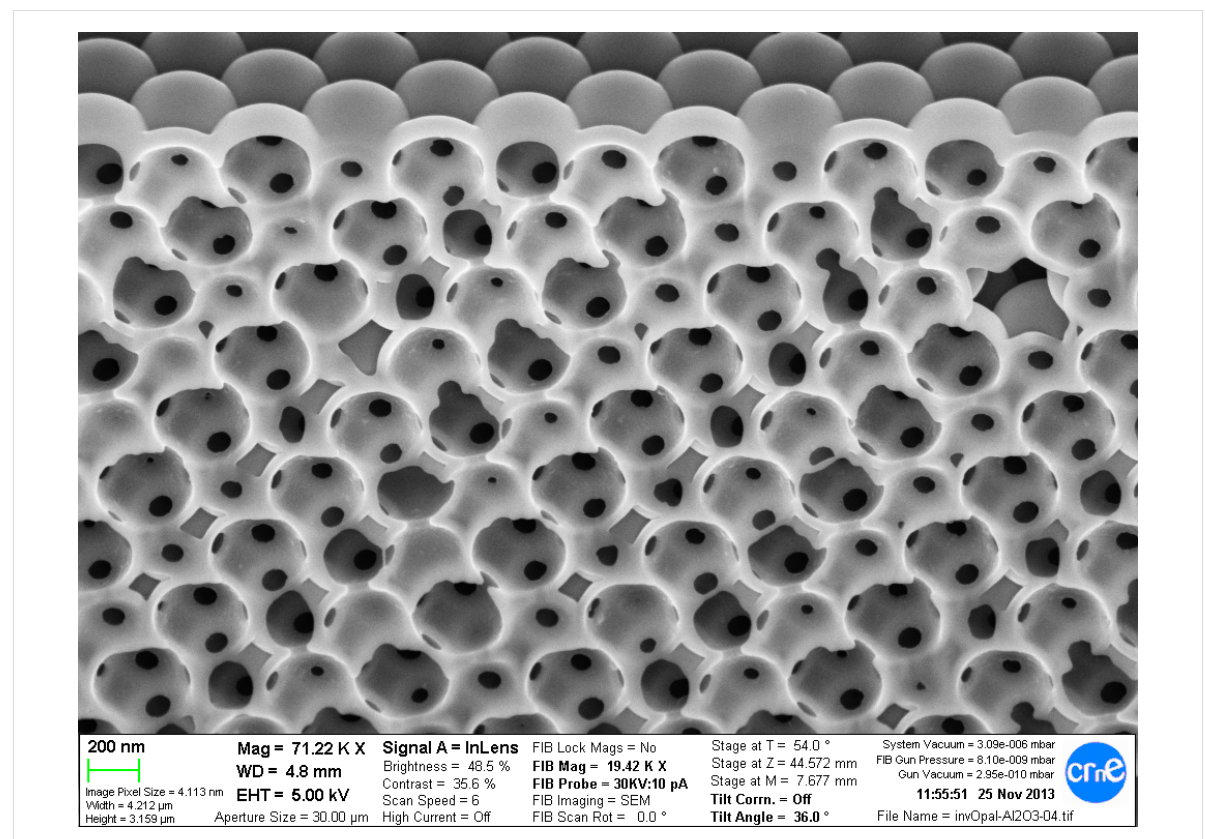
Figure 3: Cross section of Al 2 O 3 shells after complete removal of polystyrene nanoparticles. Conformal shells which were formed in the gaps be- tween nanoparticles are seen. The dark contrast areas in the shells are locations where the former polystyrene structure contact points result in uncovered